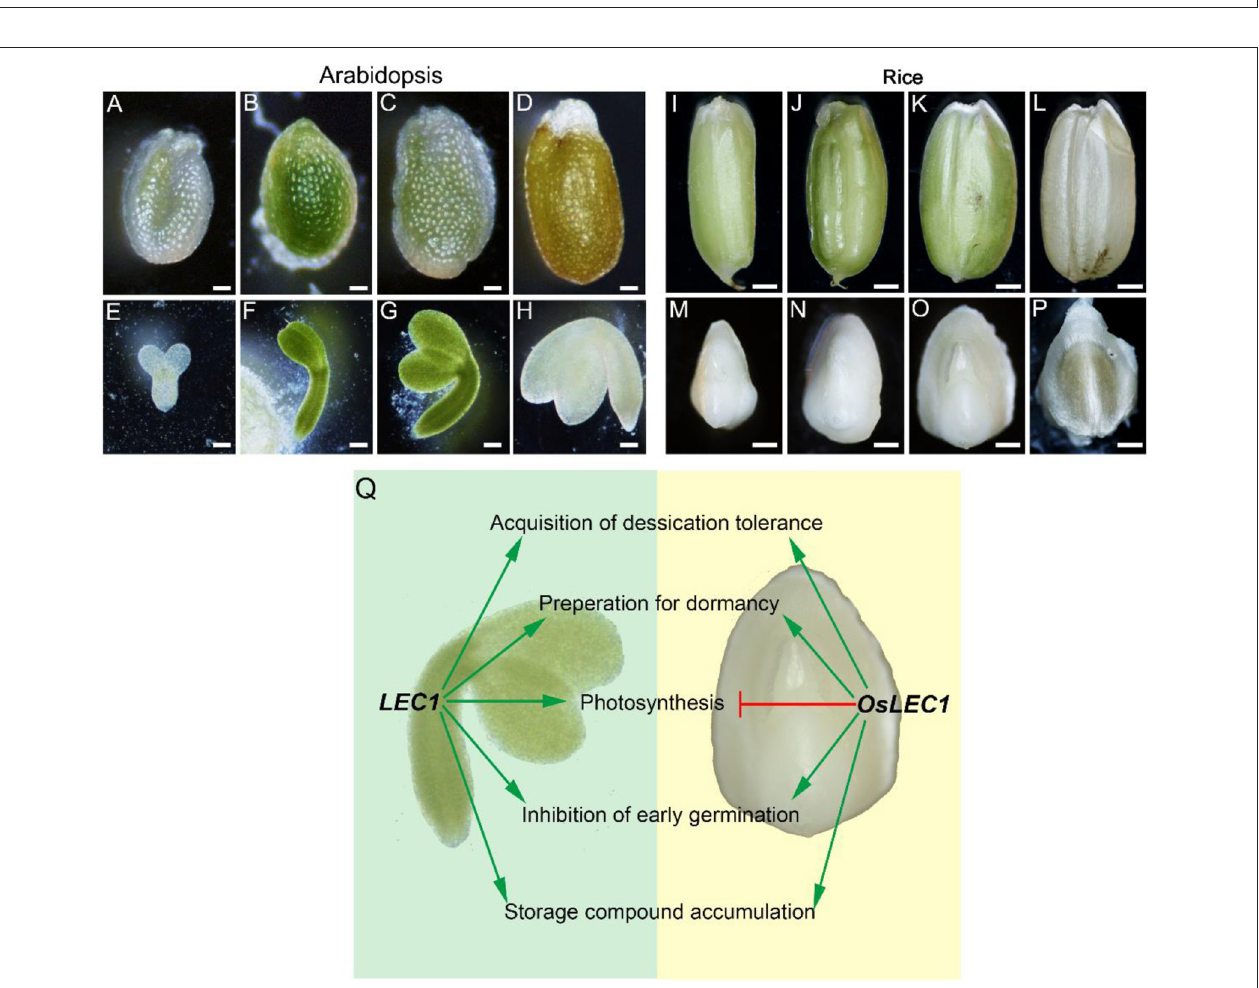
FIGURE 8 | Comparisons of LEC1 functions during seed development in rice and Arabidopsis. (A–D) Complete Arabidopsis seeds in different developmental stages. Scale bars = 200 µ m. (E–H) Arabidopsis embryos in different developmental stages. Scale bars = 50 µ m. (I–L) Complete rice seeds in different developmental stages. Scale bars = 500 µ m. (M–P) Rice embryos in different developmental stages. Scale bars = 50 µ m. (Q) Comparison of LEC1 functions during seed development in rice and Arabidopsis. Arrowed green lines represent promotional effects, and a flat red line show inhibitory